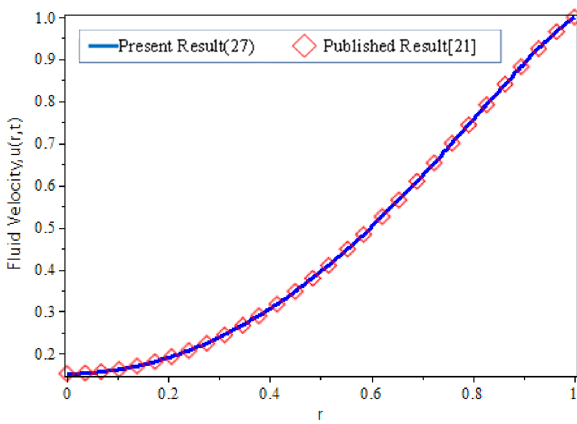
Figure 4. Validation current work with the published result 21 .